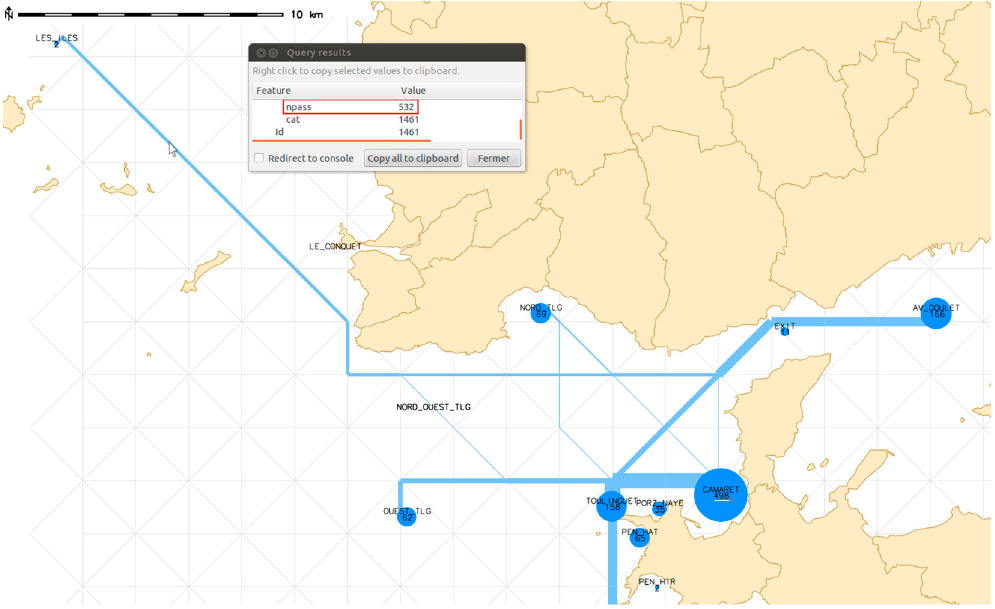
Figure 7. Screenshot of a sample result in output from v.createRoutes.py for the Toulinguet sémaphore.